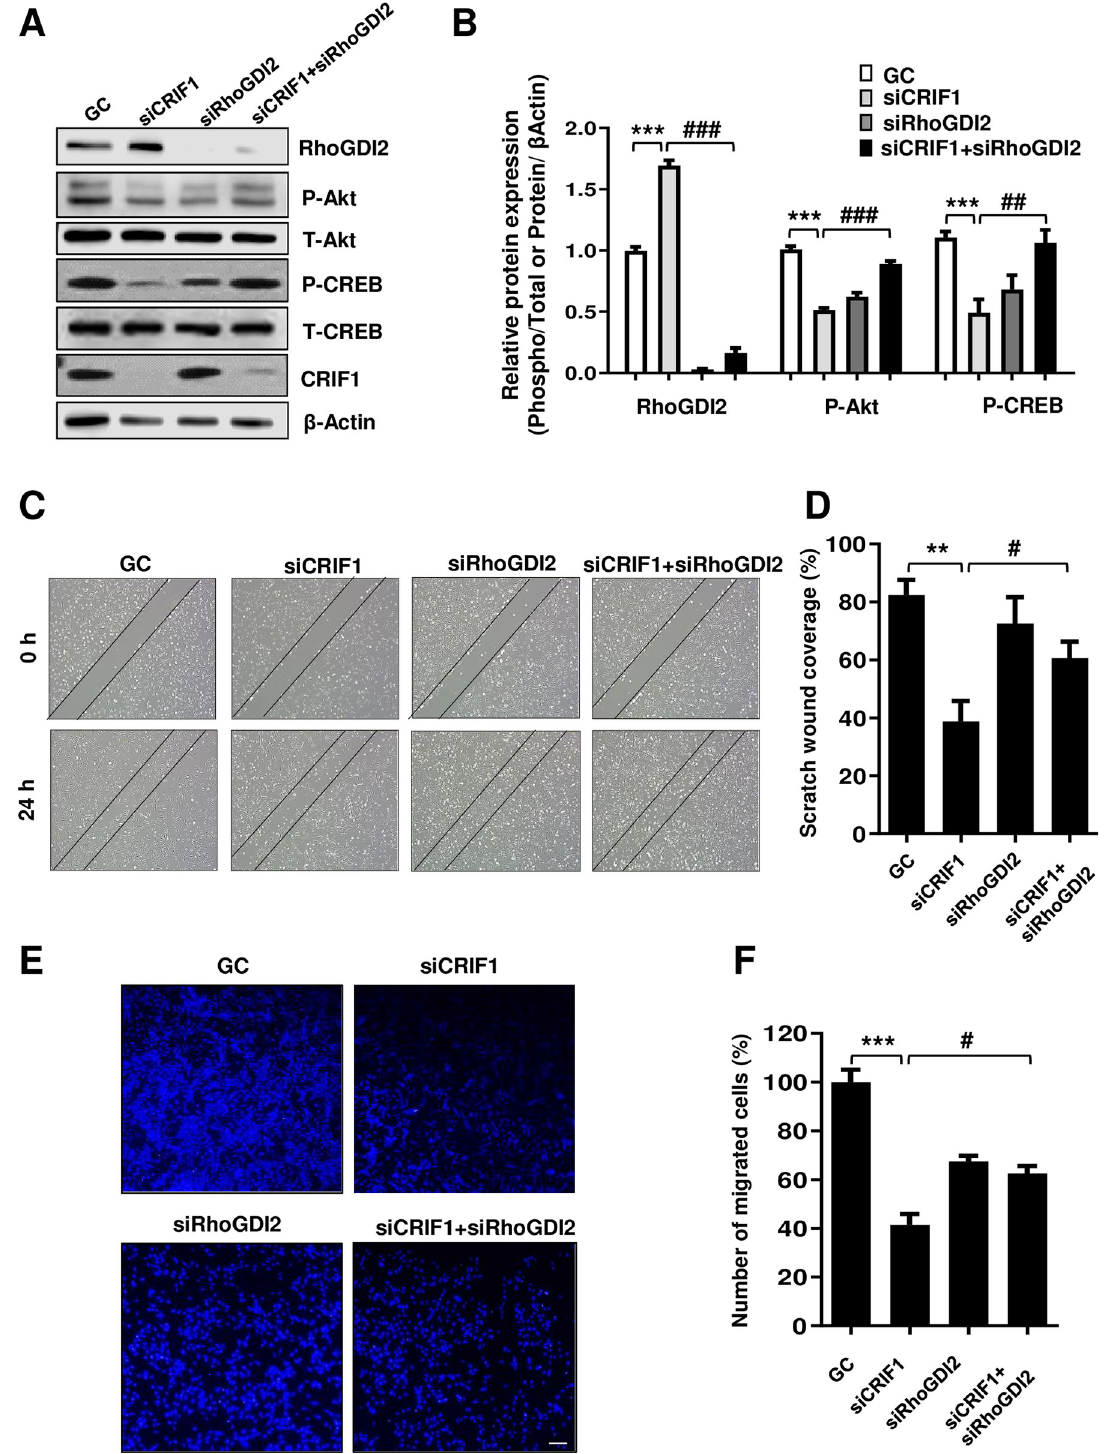
Fig 2. RhoGDI2 knockdown in CRIF1-silenced HUVECs leads to activation of the Akt-CREB signaling pathway and restoration of endothelial cell migration. (A) HUVECs were transfected with the control, CRIF1 siRNA, or co-transfected with CRIF1 and RhoGDI2 siRNA (100 pmol) for 48 h followed by western blot analysis of phospho-Akt and phospho-CREB levels. (B) Protein levels were quantified by densitometric analysis using ImageJ software. (C) HUVECs were transfected with the control, CRIF1 siRNA, or co- transfected with CRIF1 and RhoGDI2 siRNA (100 pmol) and incubated for 24 h. Next, the cells were wounded for 24 h. Images were